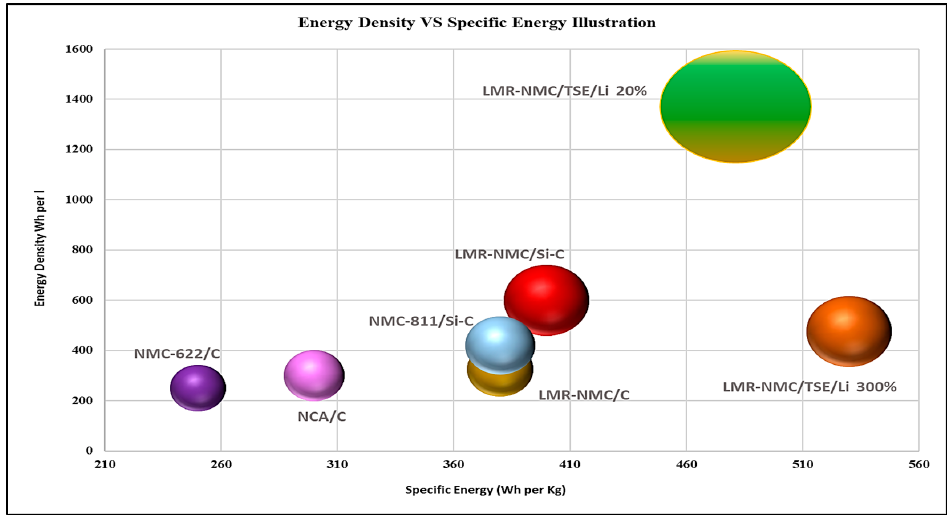
Figure 3. Illustration of Energy density vs. speci fi c energy.